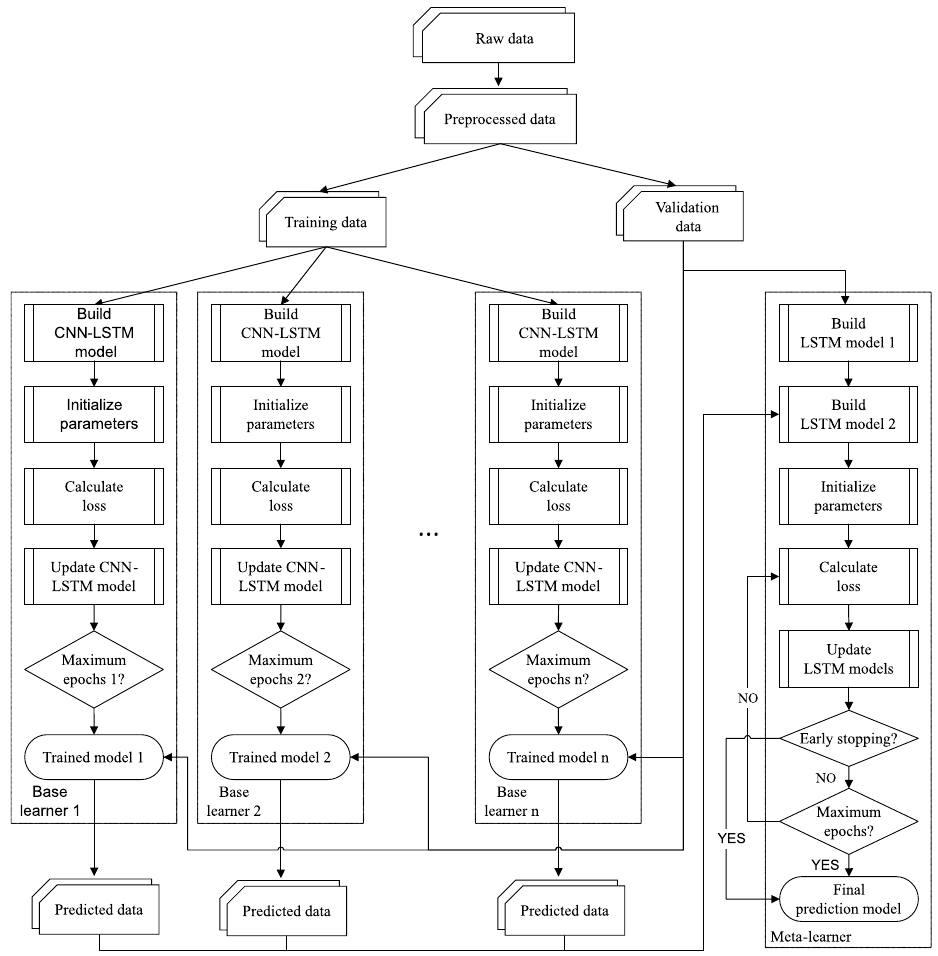
Figure 4. The training flow of the proposed ensemble model. The original dataset is divided into training and validation data subsets. The former is utilized for training multiple base models. The meta-learner is trained using validation data and predicted results produced by the trained base